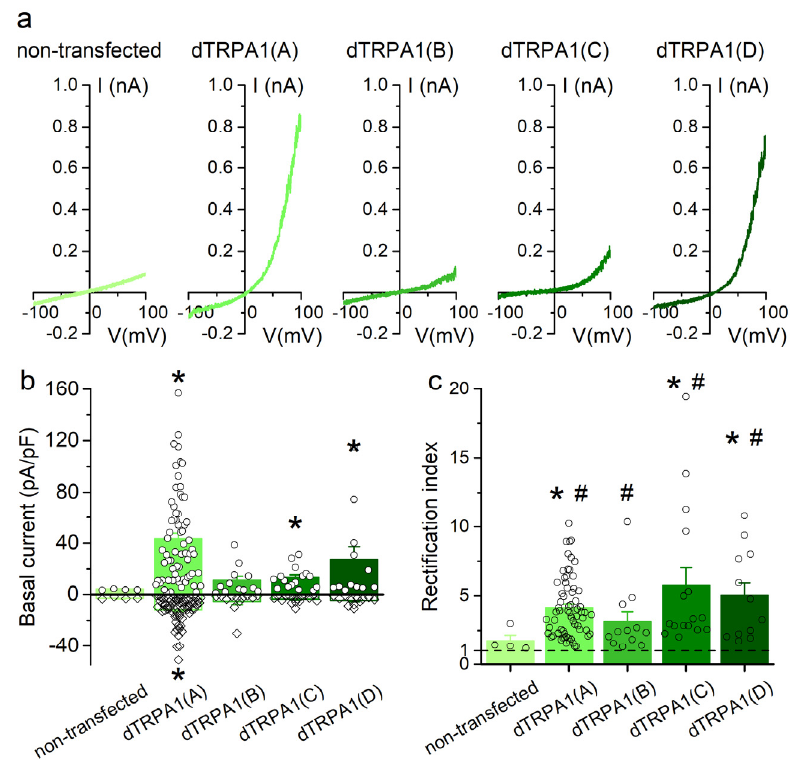
Figure 2. Basal currents recorded in HEK293T cells expressing dTRPA1 isoforms. ( a ) Examples of basal (non-stimulated) currents recorded in non-transfected cells and in cells expressing either of the four dTRPA1 channel isoforms. ( b ) Average basal current density determined at +75 mV (filled bars) and − 75 mV (open bars) in non-transfected and in cells expressing dTRPA1(A), dTRPA1(B), dTRPA1(C) or dTRPA1(D) (n = 4, 66, 12, 16 and 12, respectively). ( c ) Average rectification index determined for the same cells as in ( b ). The * symbols indicate p < 0.05 compared to non-transfected cells, with Kruskal-Wallis test. The # symbols indicate p < 0.05 compared to 1, with Wilcoxon signed rank test.